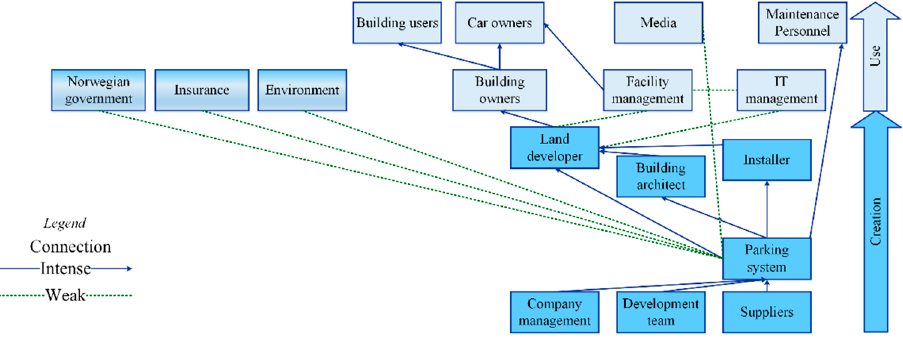
Figure 8. Value network.